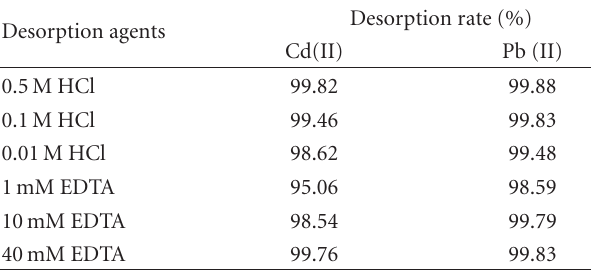
Table 1: E ff ect of di ff erent concentration of EDTA and HCl on desorption of